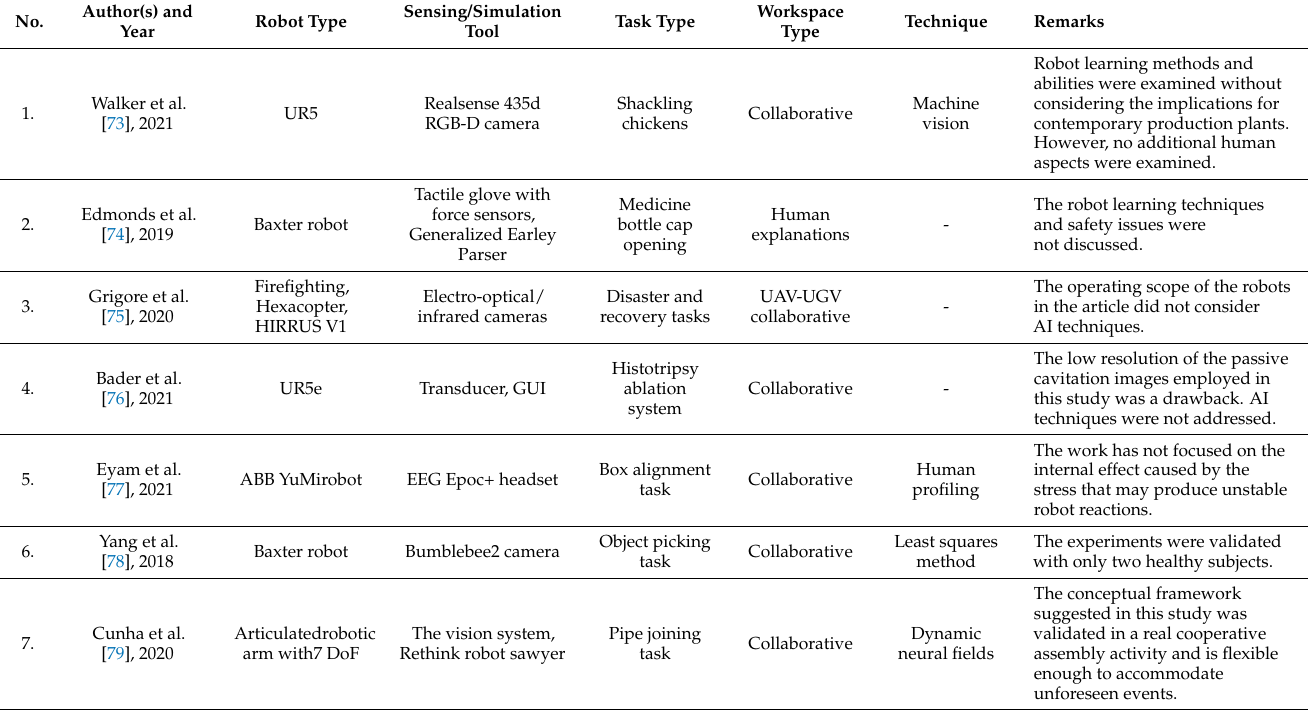
Table 5. Summary of cobot-related works without